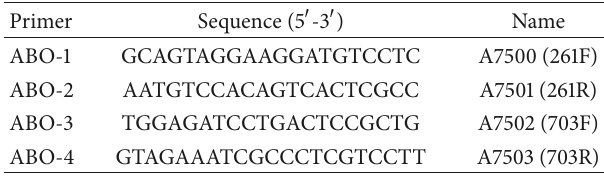
Table 1: Primer in ABO polymorphism identification. Primer